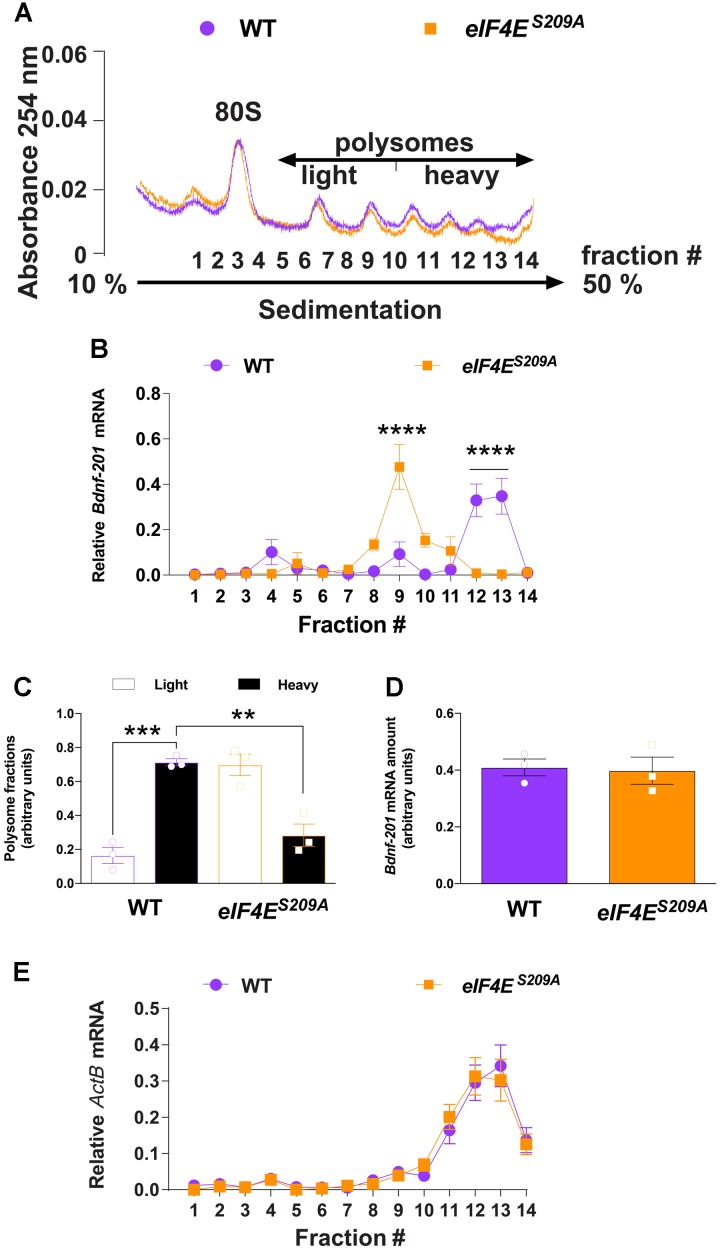
Bdnf-201 mRNA localizes to lighter polysomes in eIF4ES209A mouse DRGs. Polysome profiling of DRG lysates from WT and eIF4ES209A mice (A). (B,C) The relative amount of Bdnf-201 mRNA in the heavy (fraction 10–14) vs. light (fraction 5–9) polysome fractions was decreased in eIF4ES209A mouse DRG indicating decreased Bdnf-201 mRNA translation [B, n = 3, F(13,56) = 12.5, p < 0.0001; post hoc Bonferroni’s ∗∗∗∗p < 0.0001; C, n = 3, F(3,8) = 28.78, p = 0.0001; post hoc Bonferroni’s ∗∗∗p = 0.0002, ∗∗p = 0.0011 one-way ANOVA]. (D) Total Bdnf-201 mRNA amount did not differ between genotypes in samples used for polysome analysis (n = 3). (E)
ActB mRNAs localize to heavy polysomes in both WT and eIF4ES209A DRGs.